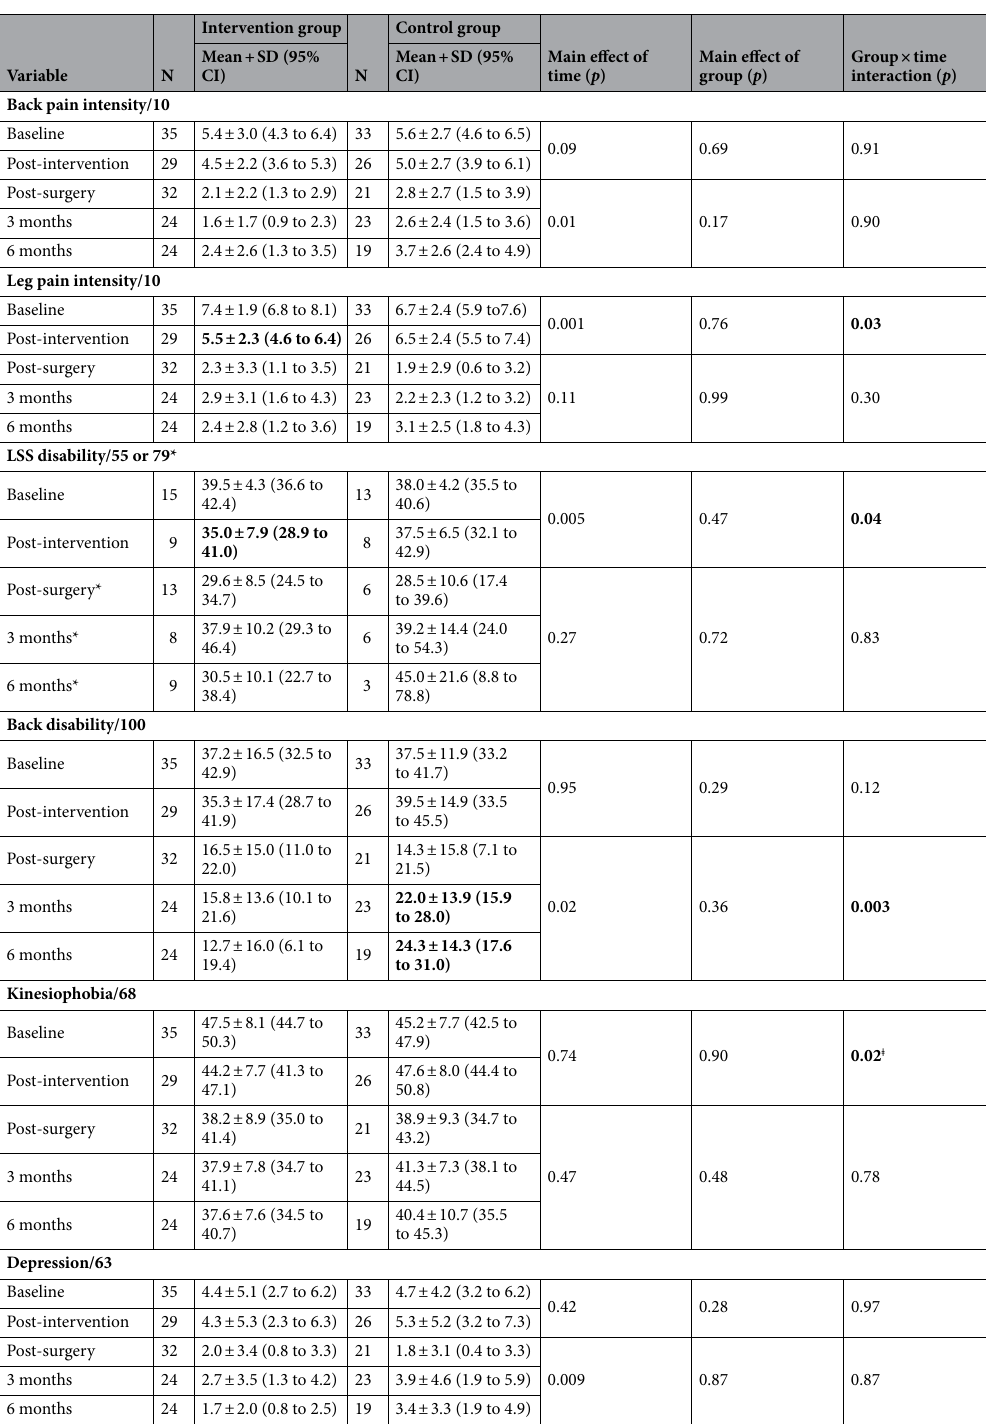
Table 2. Results for clinical outcome measures. SD standard deviation, CI confidence interval. *LSS- related disability measured using the Swiss Spinal Stenosis Questionnaire—maximum score at baseline and post-intervention assessments is 55 (includes symptoms and function subscales) and maximum score at postoperative, 3-month and 6-month assessments is 79 (includes symptoms, function and satisfaction subscales). ǂ The Group × Time interaction term was statistically significant but post-hoc analysis using Bonferroni test revealed no significant within or between group differences. Bold indicate a significant intra- group change from baseline (for analyses conducted between baseline and post-intervention assessments) or intra-group change from post-surgery (for analyses conducted between post-surgery and follow-ups